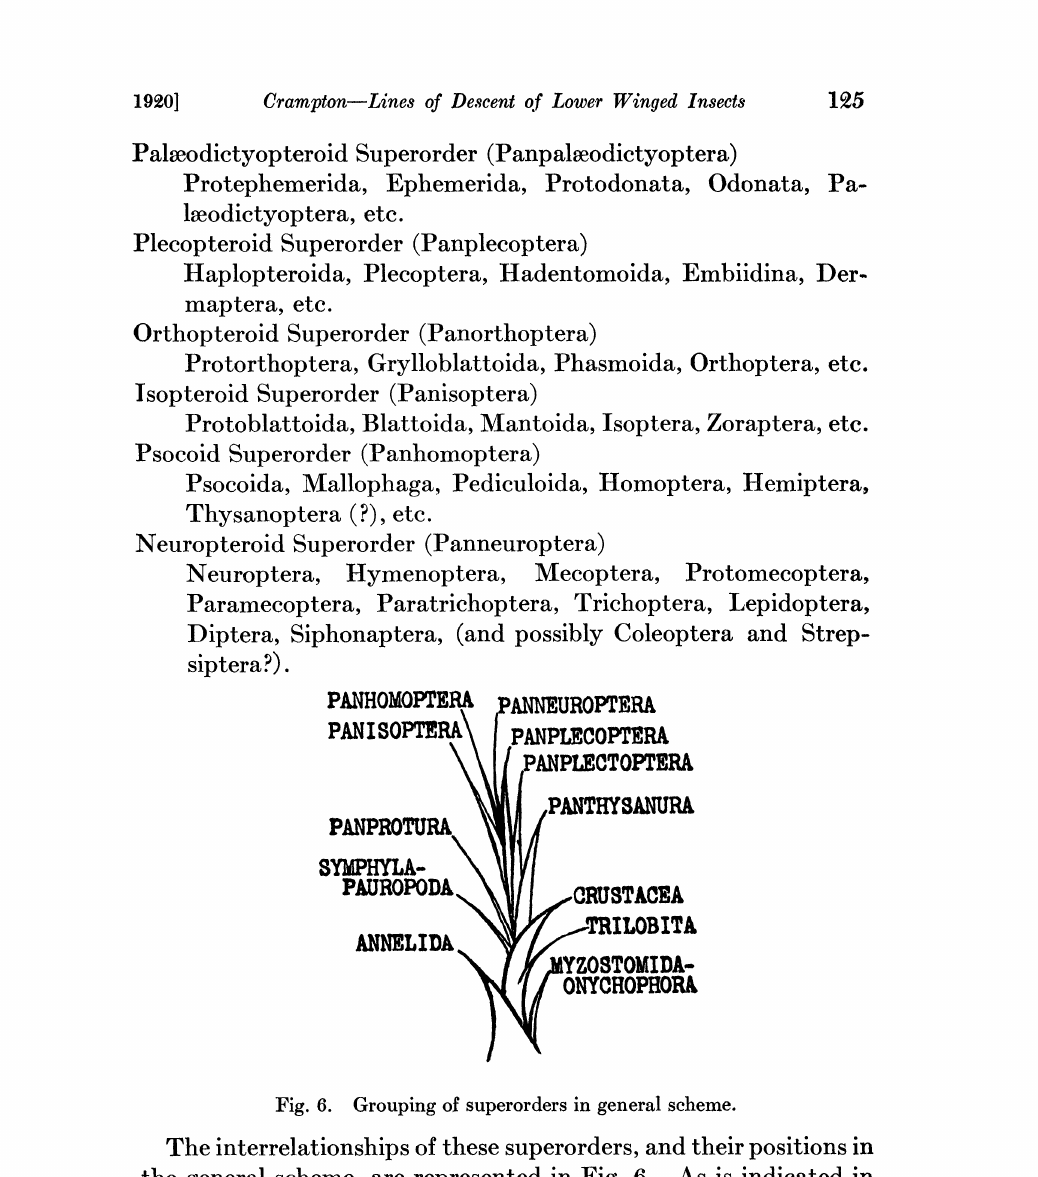
Fig. 6. Grouping of superorders in general